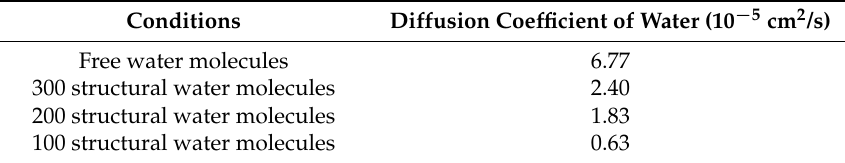
Table 4. Calculated diffusion coefficient of free water and structural water in